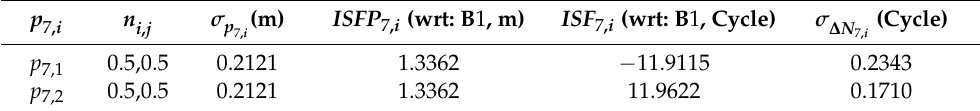
Table 2. The optimized pseudorange combinations and cycle-slip combinations of dual-frequency